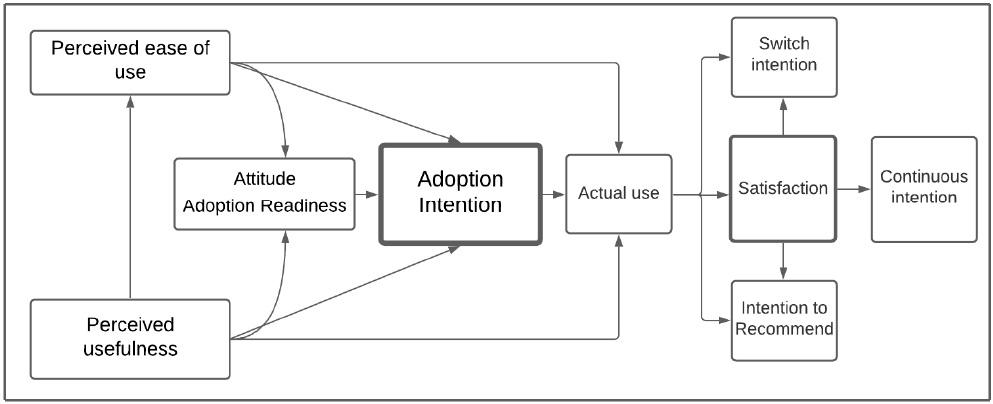
Figure 3. The general electronic payment behaviour